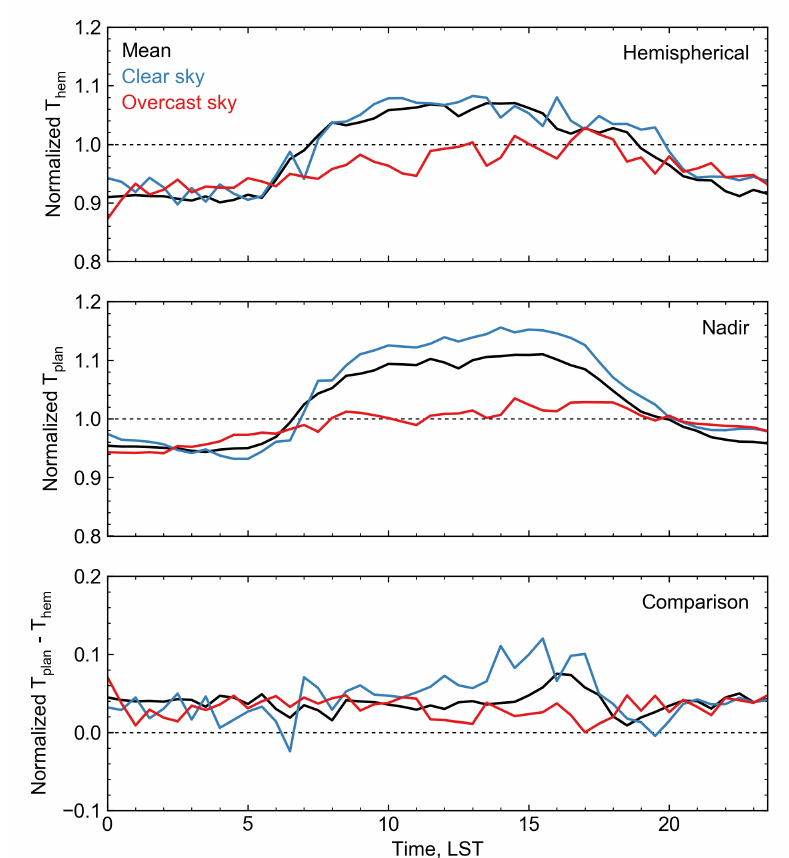
Figure 13. Normalized T hem, r , T plan , and ∆ T plan − hem, r averaged over 26 June 2002 through 9 July 2002 during the IOP and for clear sky and overcast days over the same period; n = 14